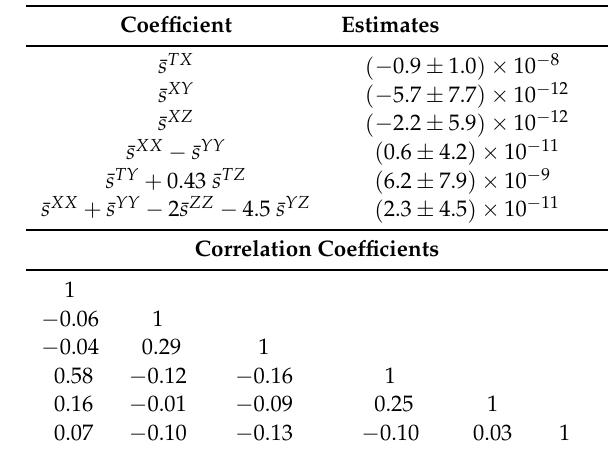
Table 3. Estimation of SME coefficients from a full LLR data analysis from [46] and associated correlation